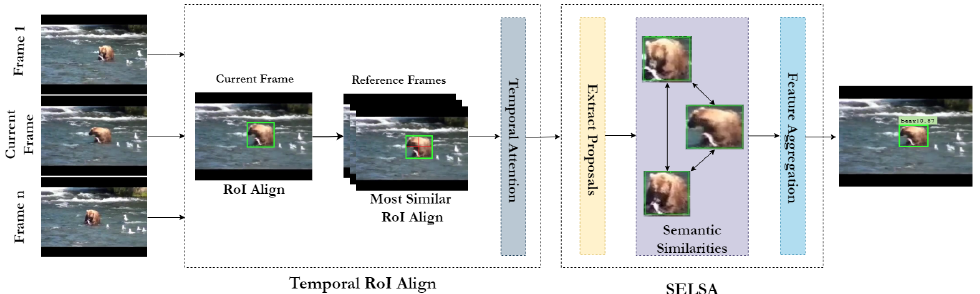
Figure 6. Overview of the aggregation head implemented using SELSA and Temporal RoI